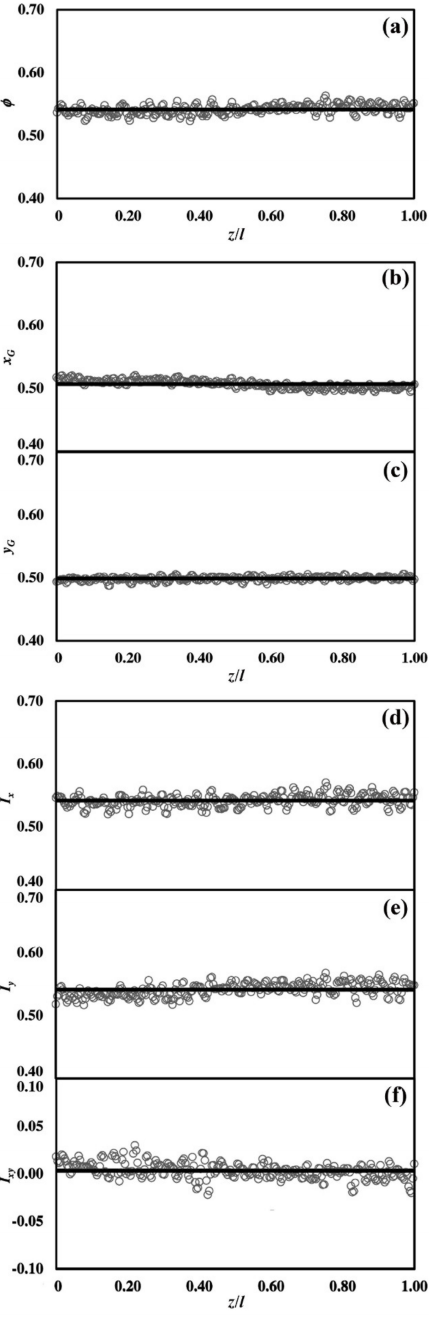
Figure 2. The NP ( a ) Volume fraction φ , ( b , c ) centre of mass position ( x G , y G ) , and ( d – f ) mo- (cid:0) (cid:1) I x , I y , I xy ments of inertia along the longitudinal direction z / l . The average values φ = 0.5416, (cid:0) (cid:1) = ( (cid:0) (cid:1) = ( x G , y I x , I y , I xy 0.5069, 0.4988 ) and 0.5420, 0.5409, 0.0032 ) are shown as black continu- G ous